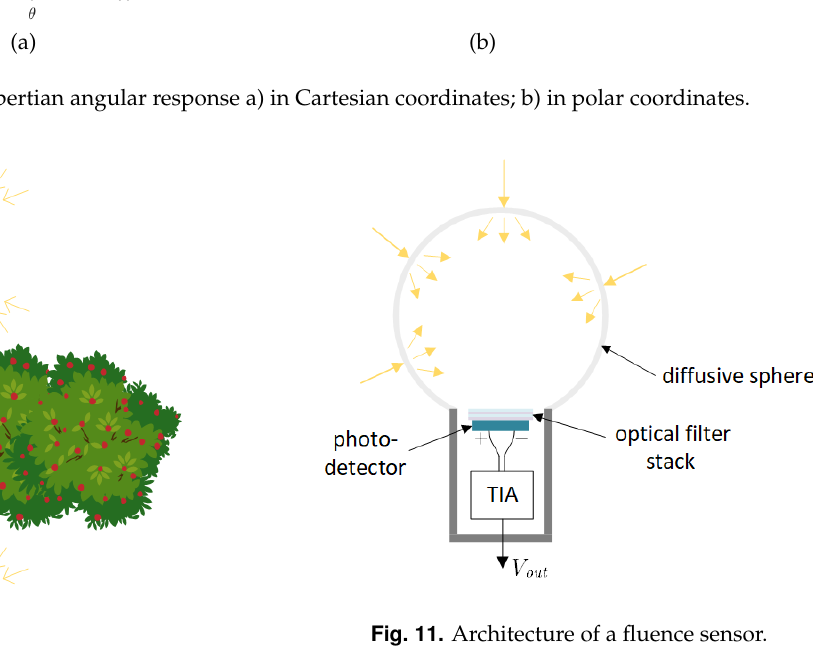
Fig. 11. Architecture of a fluence